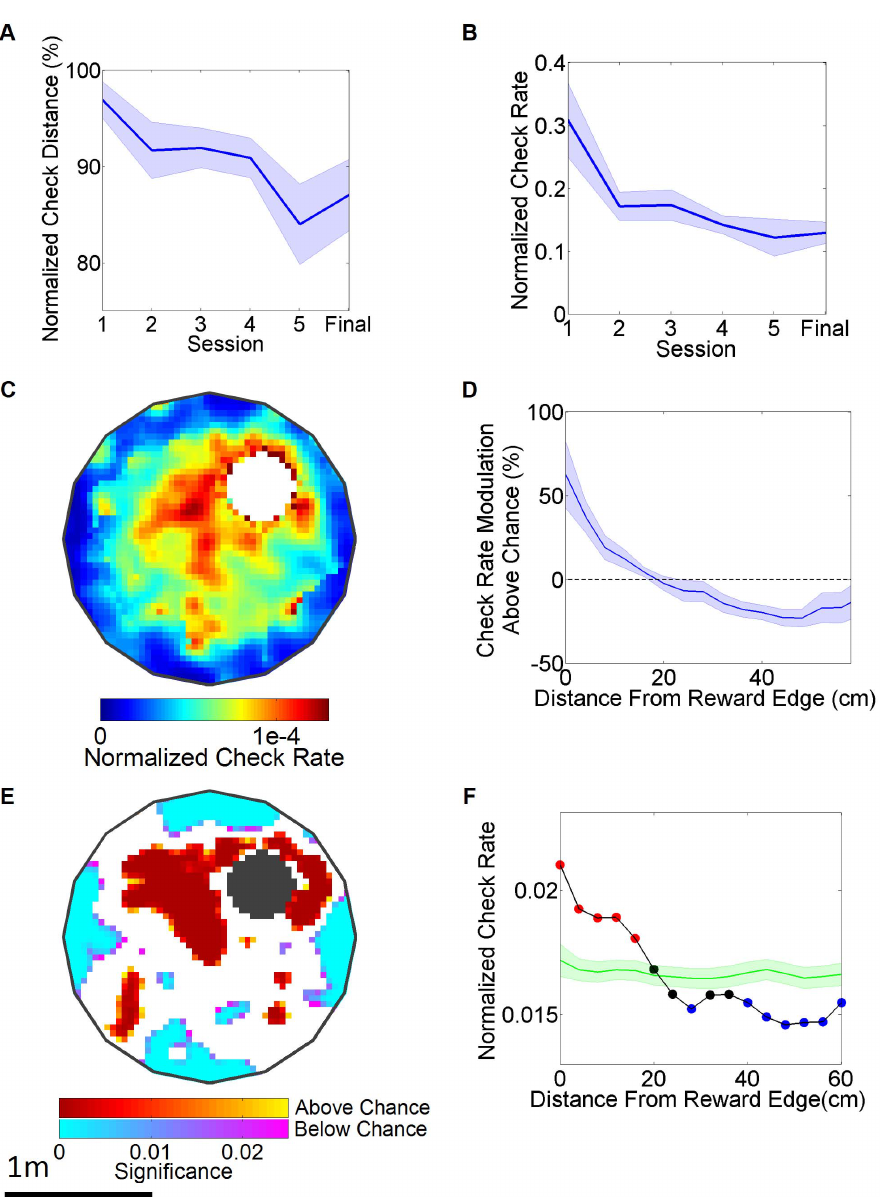
Figure 2. Analysis of reward checking behavior during the virtual audiovisual spatial navigation task. (A) Acquisition curve of normalized check distance across sessions and during final task performance. This is calculated as: Mean actual distance/Mean randomized distance x 100. Note that the 6 th day of acquisition was lost to malfunction of capacitive sensor. ‘‘Final’’ indicates performance average across the final four task sessions. Effect of session: F(5,35) =3.384, p=0.018, p , 0.05 for 1 st vs. 5 th session, N=6. (B) Normalized check rate across sessions. Effect of session: F(5,35) =4.452, p=0.0049, p , 0.05 for 1 st vs. 4 th session (C) 2-D histogram of the normalized check rate averaged across rats during final task performance. (D) Check rate modulation as a function of radial distance away from the reward zone in 4 cm radial bins for final task performance. Effect of bin, F(14,89=9.241, p , 0.0001, p , 0.05 for closest bin relative to 3rd through 15th bins. (E) 2-D p-value map of a single rat’s performance during the final task performance. Red indicates regions where checking behavior was significantly modulated above chance (p , 0.01) and blue indicates regions where checking behavior was significantly below chance. (F) Example of actual checking behavior (black line) as a function of radial distance from the reward zone relative to random checking behavior (green line, with shaded SE). Red dots represent points significantly above chance and blue dots represent points significantly below chance. doi:10.1371/journal.pone.0080465.g002 quadrant in not only the visual task (mean check rate: 0.20 visual: 0.149 bits, auditory: 0.152 bits). Thus, in the presence of 6 0.06 Hz) but also the auditory task (mean check rate: distal auditory cues, the rats do show elevated reward check rate in 0.22 6 0.08 Hz, Figure 4D,E). Radial bin analysis of reward check the vicinity of the reward zone despite showing no evidence of rate and information content showed a very similar profile in both spatial learning based on traditional navigational measures. tasks, with a broad elevation in the vicinity of the reward zone (Figure 4F, Effect of trial type for information content: p = 0.78,